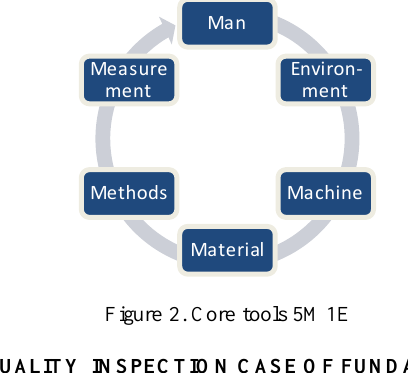
Figure 2. Core tools 5M1E